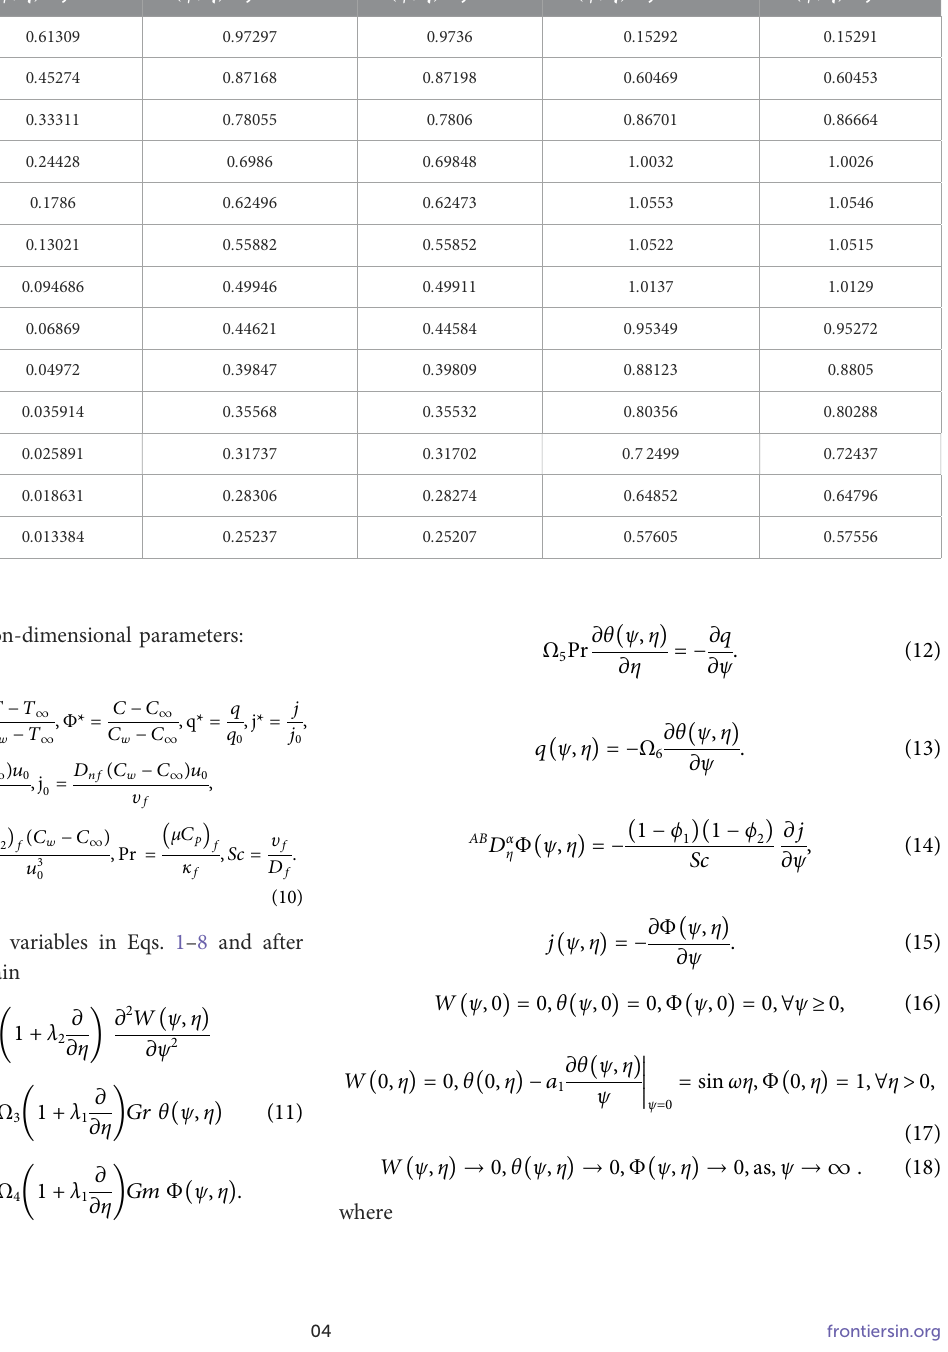
The properties of a HNF are de fi ned by Zhang et al. (2022).